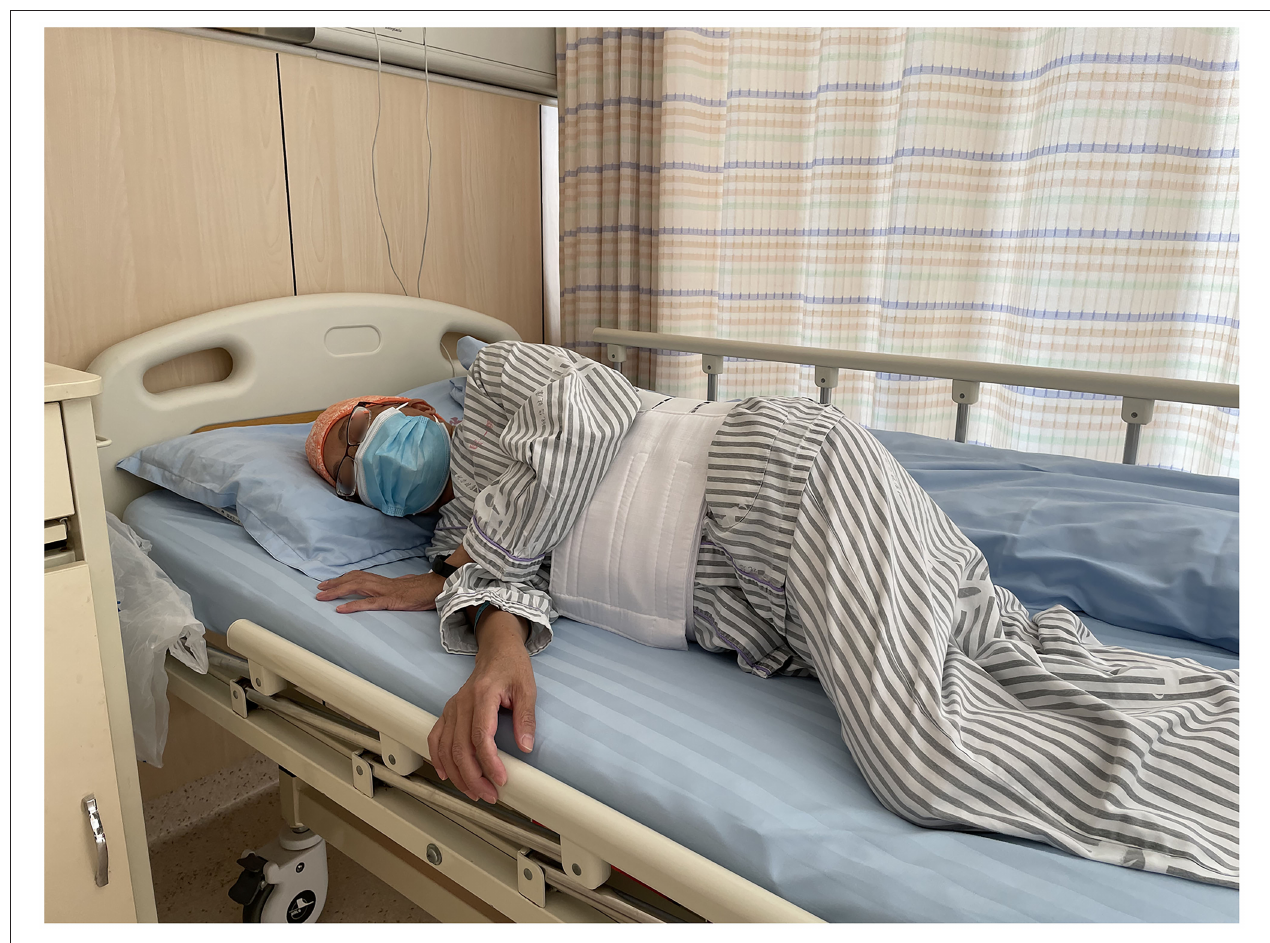
FIGURE 2 | Right side position (RRP).